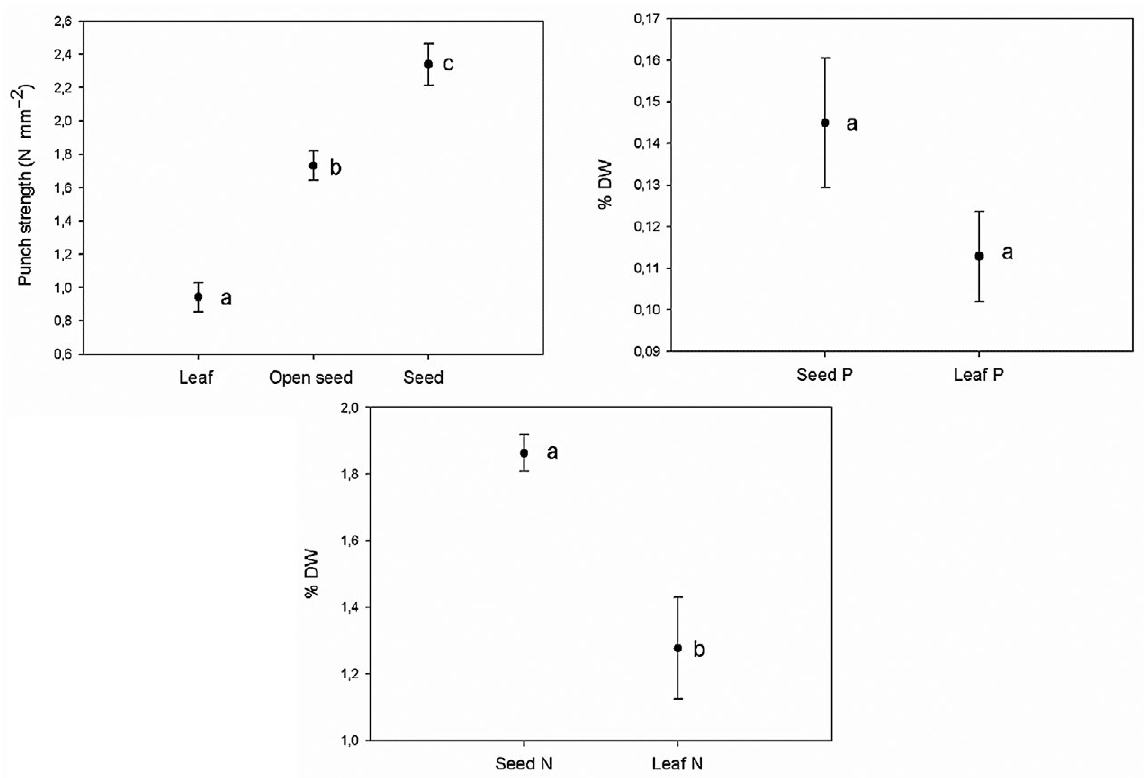
Fig. 3. – Mechanical resistance and nutrient content of leaves, open seeds and seed with coat. Error bars represent standard error. Punch strength (N mm –2 ) for leaves, open seeds and seeds with coat. Nutrient content (% DW) of seeds and leaves. Differences between groups are indicated by different